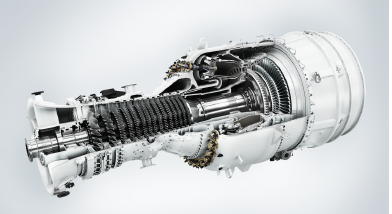
Figure 1. A unit of the gas turbine model used to perform the current analysis.